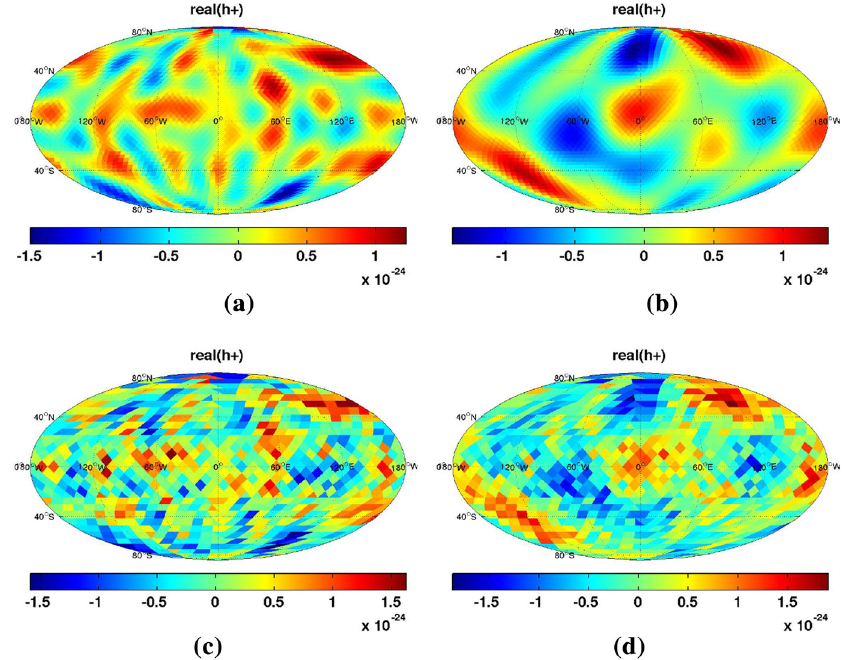
Fig. 56 Mollweide projections of the real parts of h + ( ˆ n ) for grad-only and curl-only anisotropic back- grounds injected into noise and analysed using a 3-detector network of ground-based laser interferometers (Hanford–Livingston–Virgo). The injected maps are shown in the top row ; the maximum-likelihood recov- eredmapsare shownin the second row .Skymapsofthe imaginarypart of h + ( ˆ n ) andthe real andimaginary parts of h × ( ˆ n ) are similar for both the injections and the recovered maps, and hence are not shown in the figure. Note that a network of ground-based interferometers is capable of recovering both the gradient and curl components of a gravitational-wave background, in contrast to a pulsar timing array (compare with Fig. 55). Image reproduced with permission from Romano et al. (2015), copyright by APS. a Injected grad-only map. b Injected curl-only map. c Max-likelihood recovered map. d Max-likelihood recovered